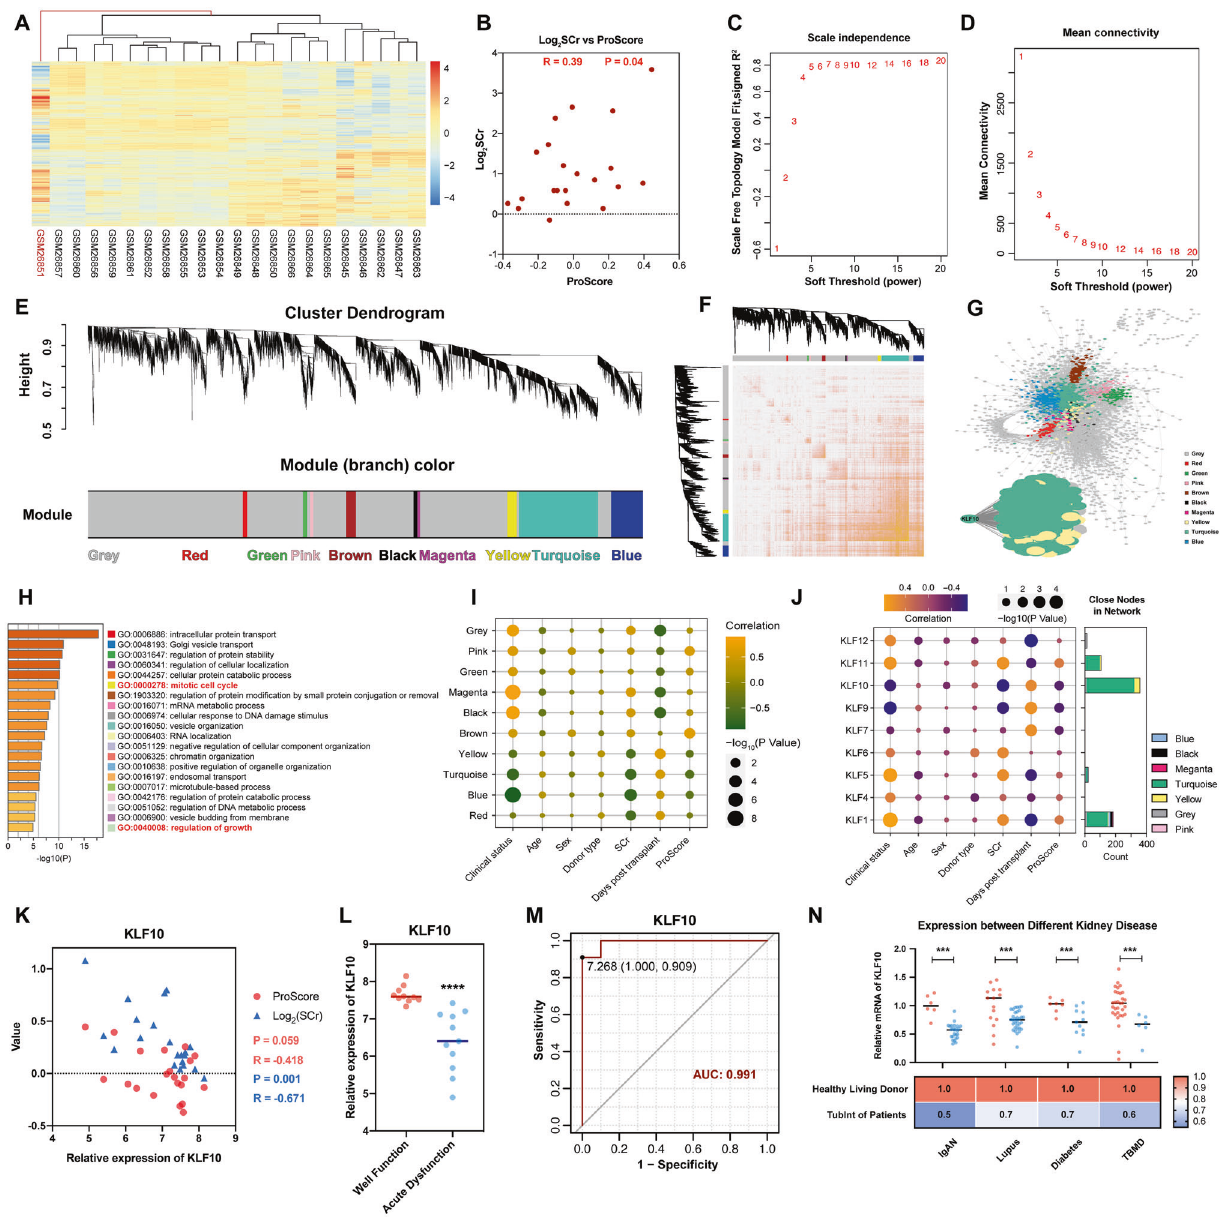
Fig. 1 Construction of weighted gene co-expression network and clinical and functional analysis of KLF10. A Heatmap with hierarchical clustering dendrogram of kidney samples in GSE1563. B Negative correlation between Epithelial Proliferation Score (ProScore) and Log 2 (Serum Creatinine). C Analysis of appropriate soft-thresholding powers for WGCNA. D Average network connectivity under weighting coef fi cients of WGCNA. E Clustering dendrograms of genes in 21 samples, from which 10 coexpression modules were constructed with different colors. F The Heatmap plot depicts the TOM among all genes in the analysis, which shows the interactions among co-expression modules. The stronger intensity of orange indicates greater overlaps. G Interaction network analysis based on WGCNA and network of KLF10 with its closely interacted genes. Each dot is color-coded by its corresponding module. H Histogram of functional enrichment analysis of genes closely interacted with KLF10. I Bubble plot of the relationship between the coexpression module and clinical data. The size shows the corresponding -log 10 ( P value) and the color represents the correlation coef fi cient. J Bubble plot of the relationship between the KLF family and clinical data with histogram displaying the number of closely interacted genes with each KLF. The size shows the corresponding -log 10 ( P value) and the color represents the correlation coef fi cient. K Negative correlation between KLF10 and ProScore/Log 2 (Serum Creatinine). L Scatter plot of relative expression of KLF10 in well function group versus acute dysfunction group. M ROC curve with AUC value of KLF10. N Scatter plot of tubulointerstitial relative expression of KLF10 in control groups versus renal disease groups. *** p < 0.001 and **** p < 0.0001 vs control group at the same experimental conditions. mixed at the ratio of 1:1 and then cultured in matrix for 6 days to visualize cell cycle progression, which showed red fl uorescence form 3D renal tubule. Puromycin was added for 12 h to induce (mCherry) in G2/M cells (Fig. 4C). To dissect the change of KLF10 in apoptosis of the sensitive cells, the rest continued to be cultured the survived cells from that in the apoptotic or necrotic one, Fucci for another 12 h or 24 h (Fig. 4D). The density of red fl uorescence renal tubule cell (without green fl uorescence) and puromycin- raised dramatically at 12 h and 24 h and then declined at 36 h resistant Fucci renal tubule cell (with green fl uorescence) were Cell Death Discovery (2023)